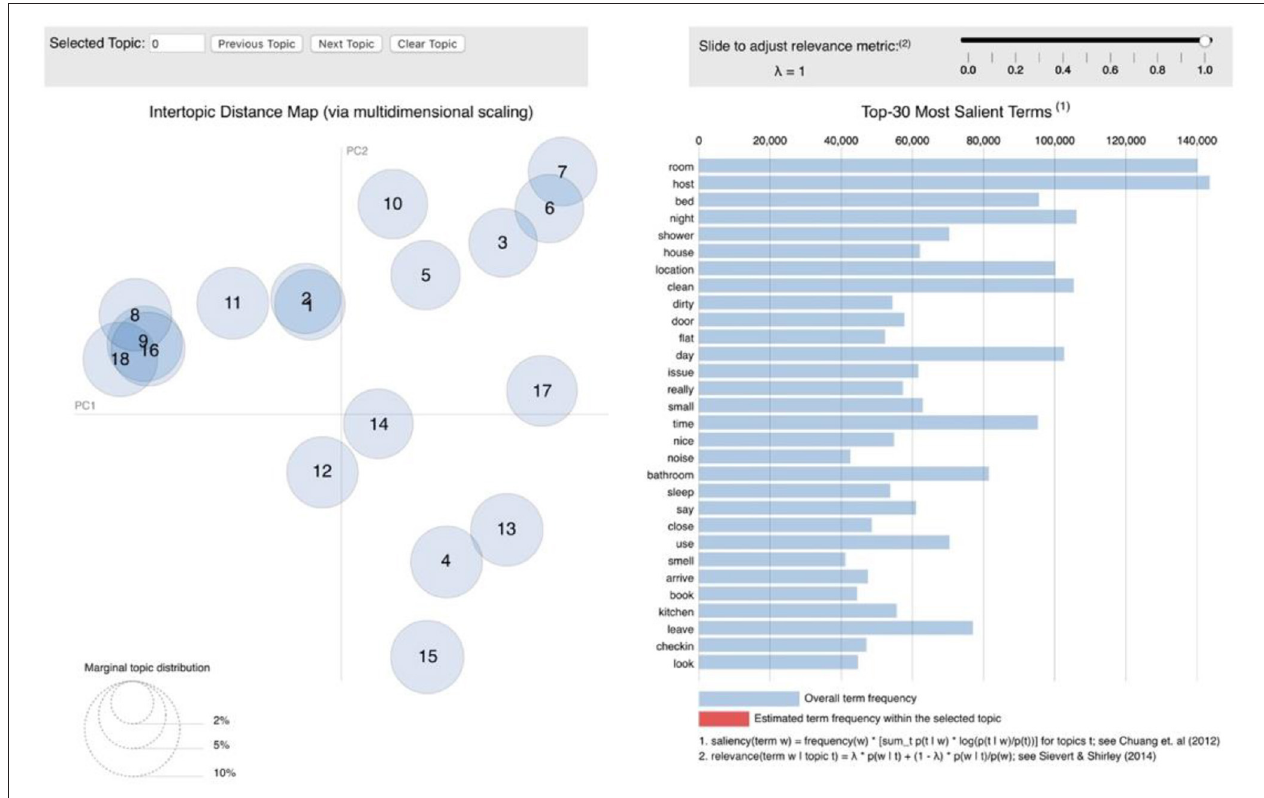
FIGURE 6 | LDAvis visualization (negative reviews). Source: created by the